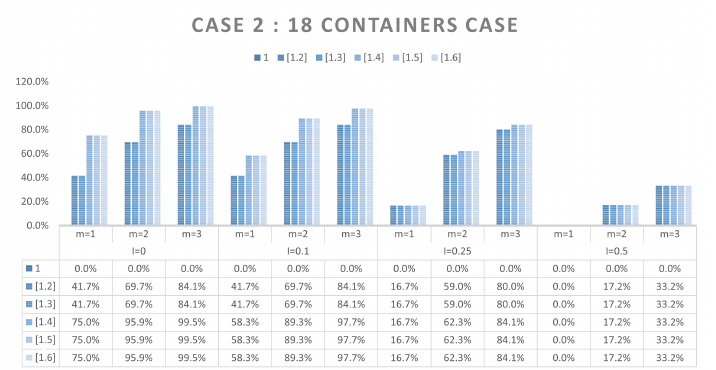
Figure 10. Histogram of the solutions number per range—18 containers